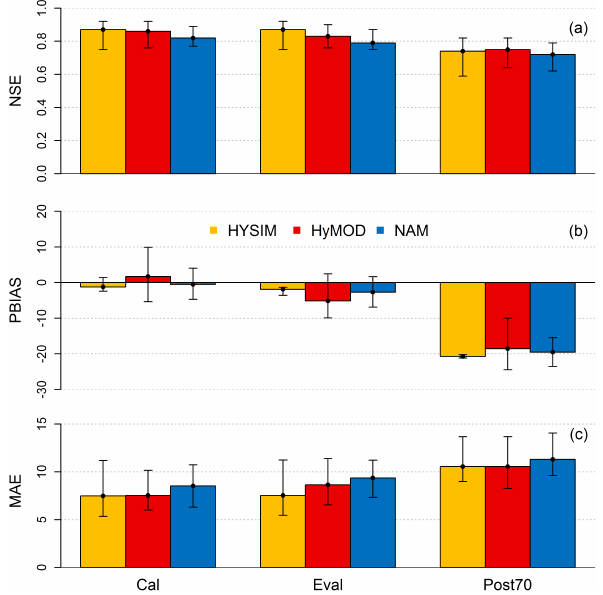
Figure 4. Objective functions (a) NSE, (b) PBIAS and (c) MAE for HYSIM, HyMOD and NAM for calibration (Cal: 1952–1959), evaluation (Eval: 1960–1969) and post-1970 (Post70: 1970–2009) periods. Each bar represents the median score for behavioural sim- ulations, with error bars giving the maximum and minimum range.